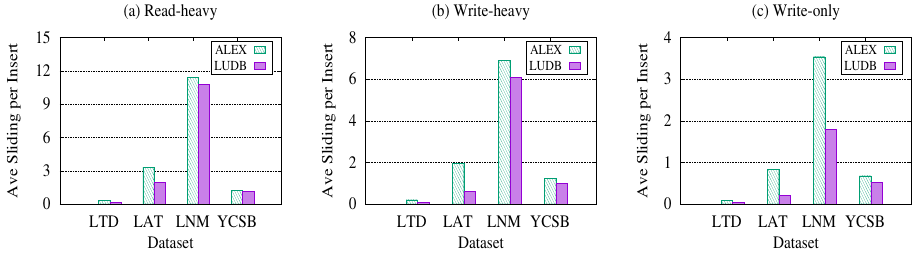
Figure 9. Average sliding per